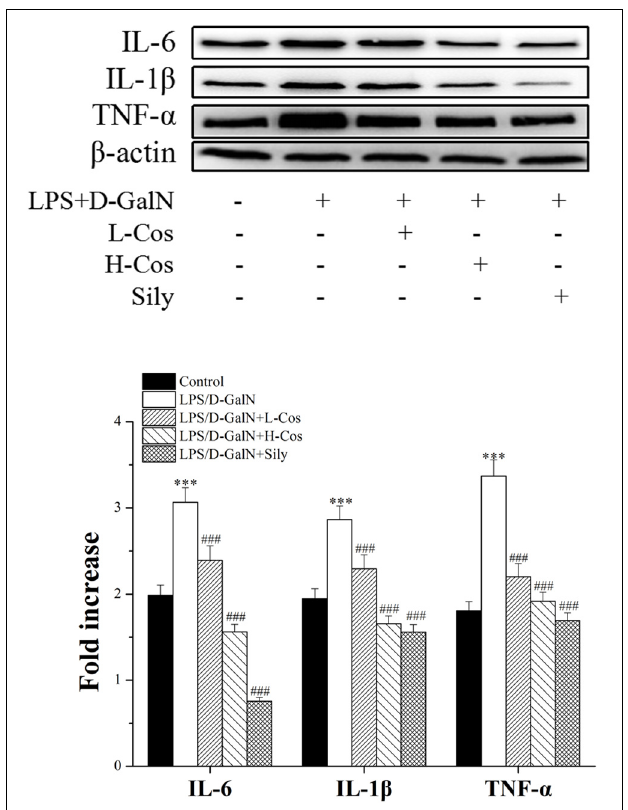
FIGURE 5 | Effects of cos on the expression of TNF- α , IL-6, and IL-1 β after LPS/ D -GalN administration by western blot analysis. The data represent the mean ± SD ( n = 10). ∗∗∗ P < 0.001 vs. control group; ## P < 0.01 and ### P < 0.001 vs. LPS/ D -GalN